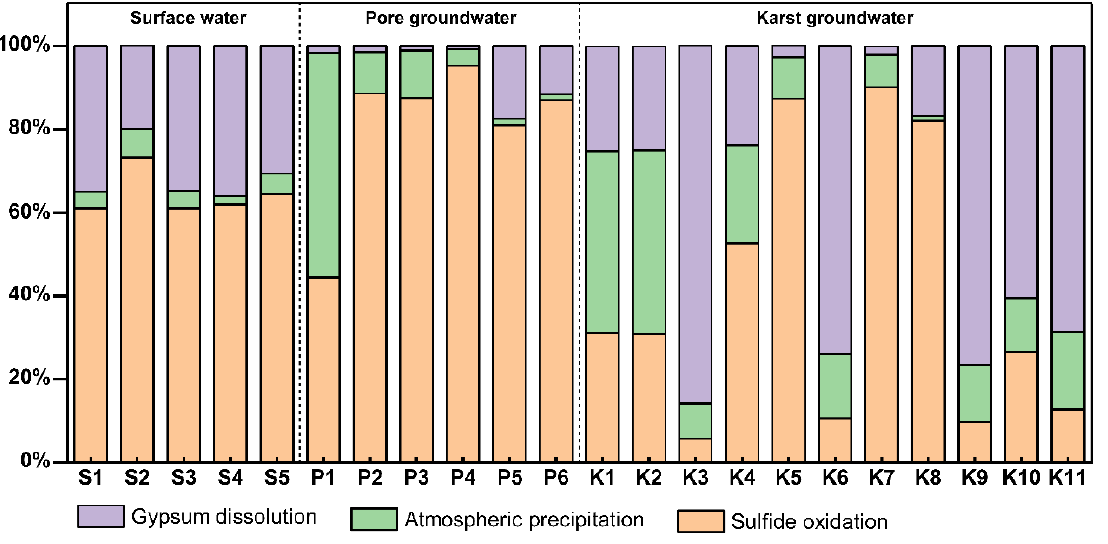
Figure 6. Explanation of sulfate sources in surface and groundwater samples in the study area based on sulfur isotope calculations.